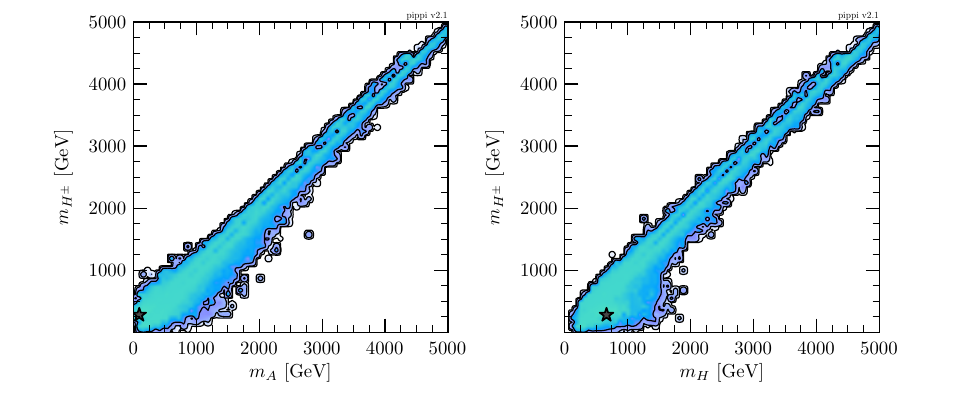
Figure 1. 2D profile likelihood distributions of electroweak precision measurements in the plane m H vs m H ± (left) and m A vs m H ± (right) . Generally the allowed region follows m H ± ≈ m A , m H . The solid lines represent 1 , 2 and 3 σ regions and the best-fit points are plotted as black